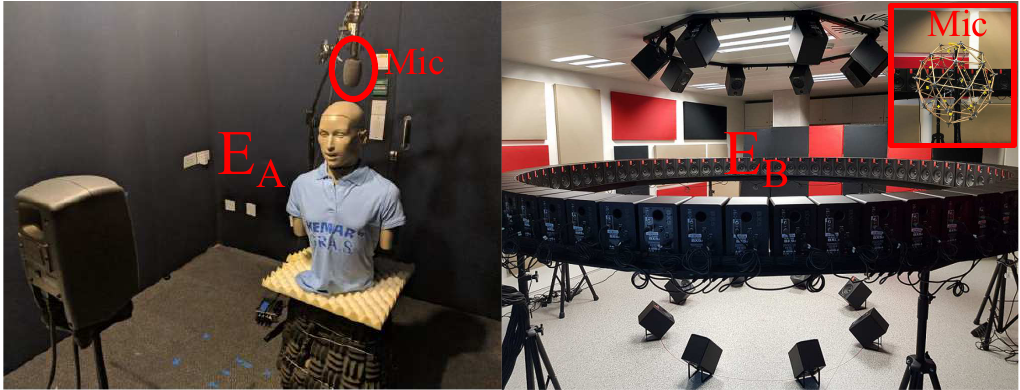
Figure 11. Examples of system setups for HRTF measurements in non-anechoic environments [154,155] (The pictures taken from publications are partly modified to highlight measurement